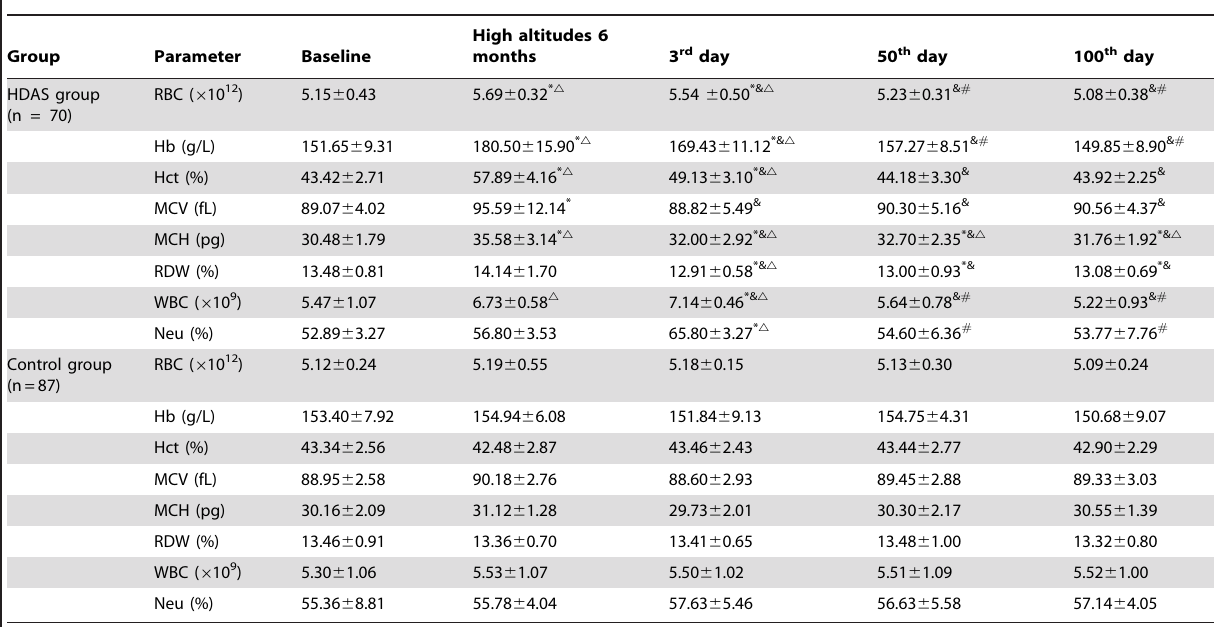
Table 7. Whole blood test results of subjects after returning to Kunming.